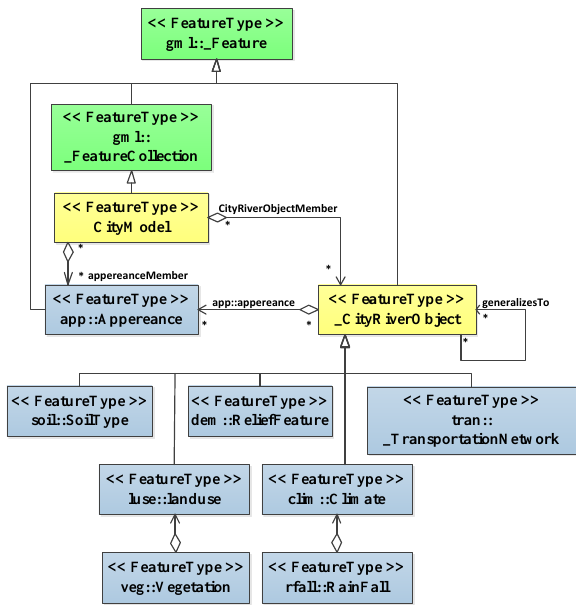
Figure 8 CityGML Thematic Field for Landscape Planning in River